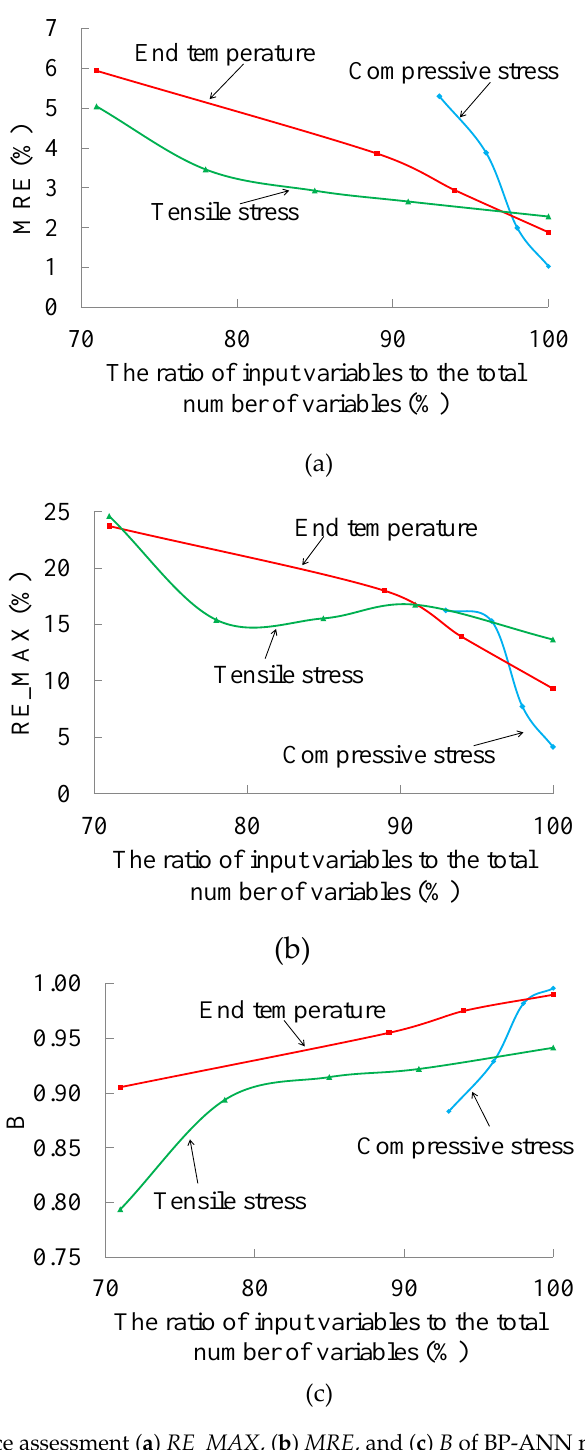
Figure 5. Performance assessment ( a ) RE_MAX , ( b ) MRE , and ( c ) B of BP-ANN models with different variable completeness (the ratio of input variables to the total number of variables). Table 7. Selection of the minimum number of input variables satisfying the predefined criteria.